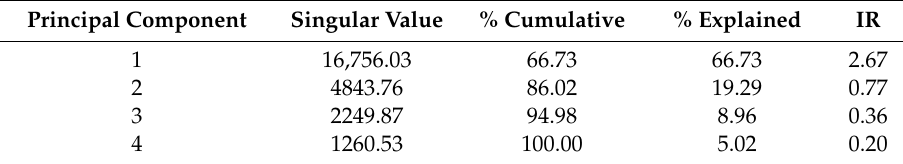
Table 5. The singular value, explained variation, cumulative ratio, and information ratio (IR) of the four principal components (PC) of the GGE biplot